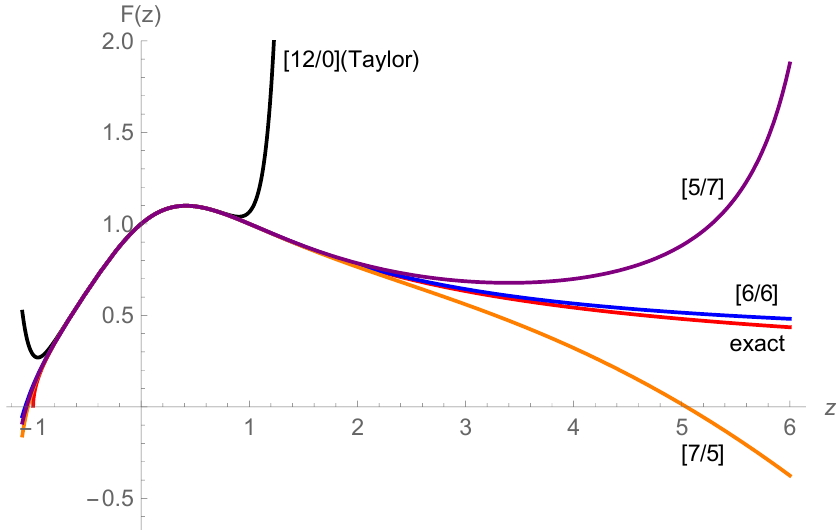
Figure A2. The Padé approximants of (A154) have good extrapolations to z > 1 where the Taylor series approximation necessarily breaks down.